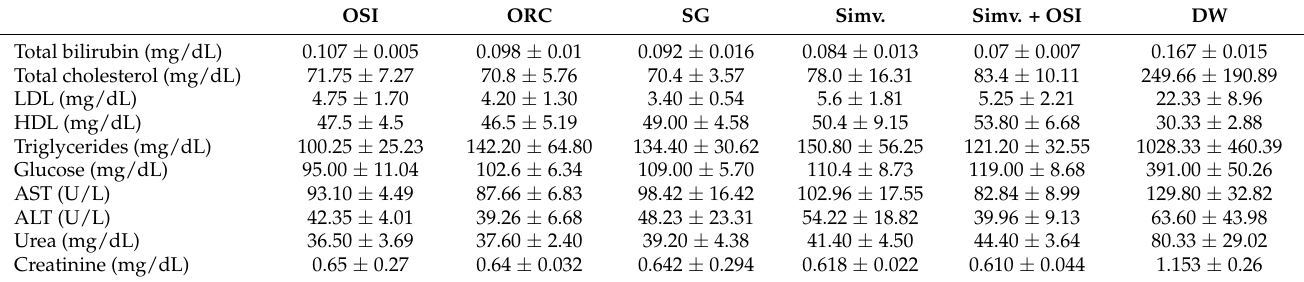
Table 1. Biochemical results (Mean ± SD).